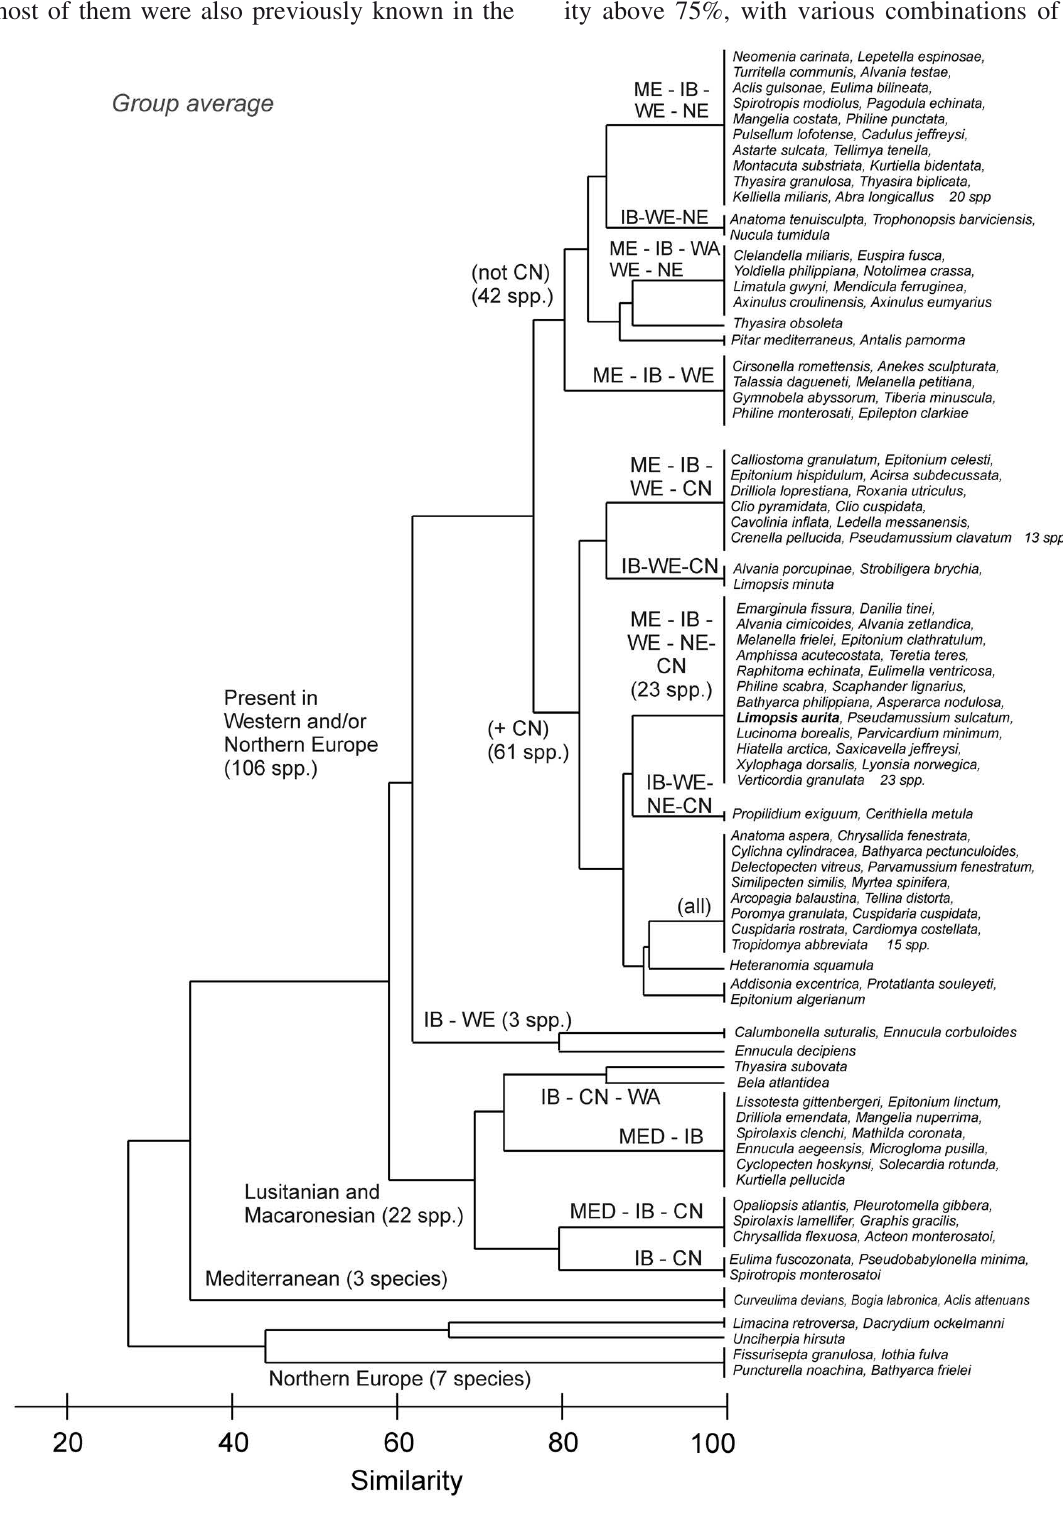
Fig. 9. – Cluster of faunal groups from different geographic areas represented in haul BT04, obtained using presence/absence data and the Bray-Curtis similarity index. (ME: Mediterranean; IB: Ibero-Moroccan Gulf; WE: Western Europe; NE: Northern Europe; CN: Canary Islands, Madeira and Lusitanian seamounts, WA: West